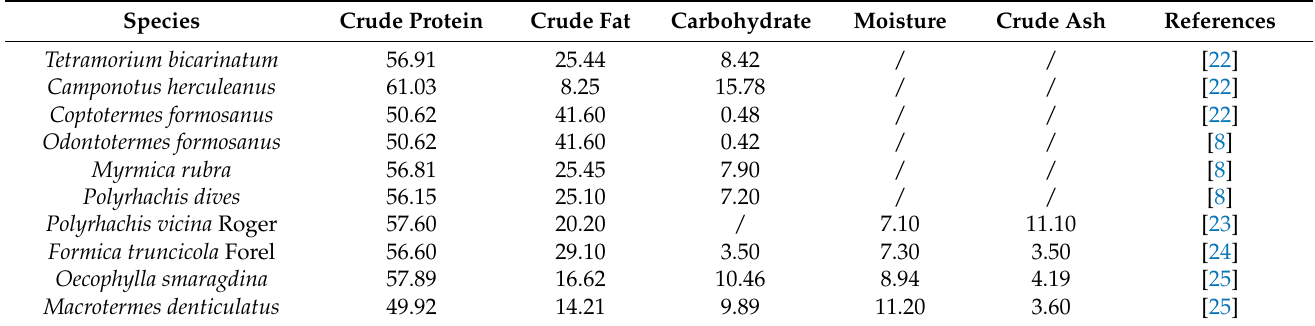
Table 1. Macronutrient concentrations across ant and termite species